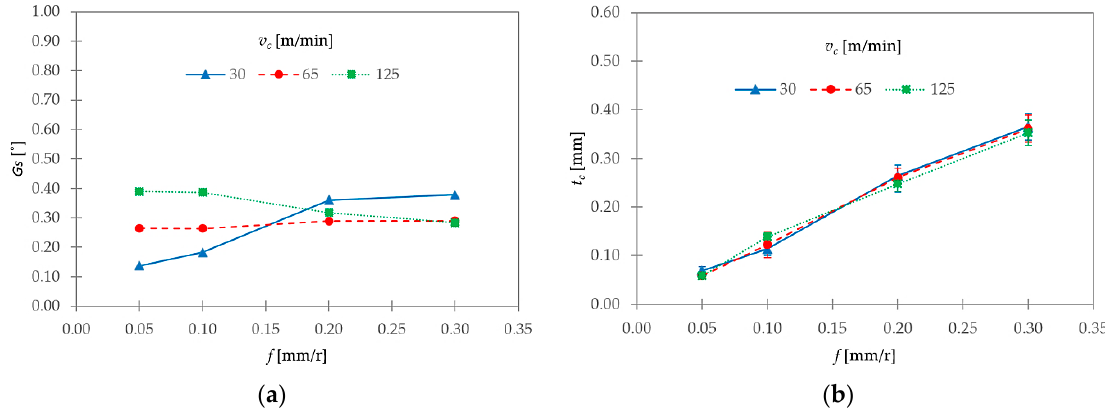
Figure 12. ( a ) Segment ratio ( G s ) and ( b ) equivalent chip thickness ( t c ) as a function of v c and f .